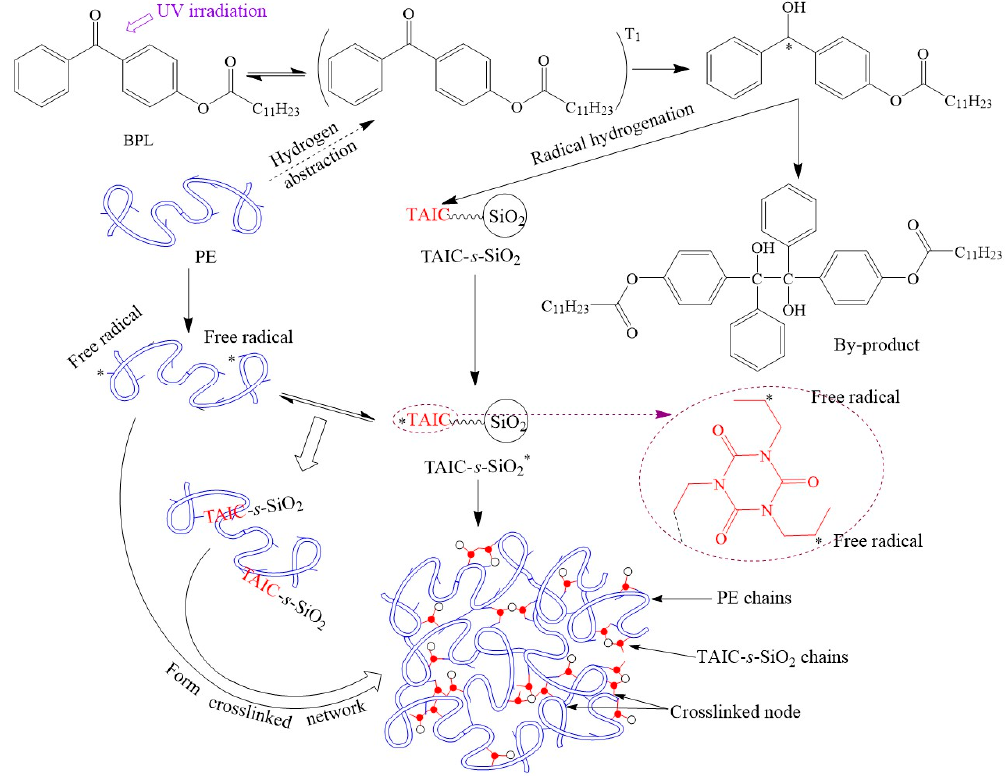
Figure 2. Schematic mechanism of polyethylene crosslinking reaction initiated by UV irradiation.